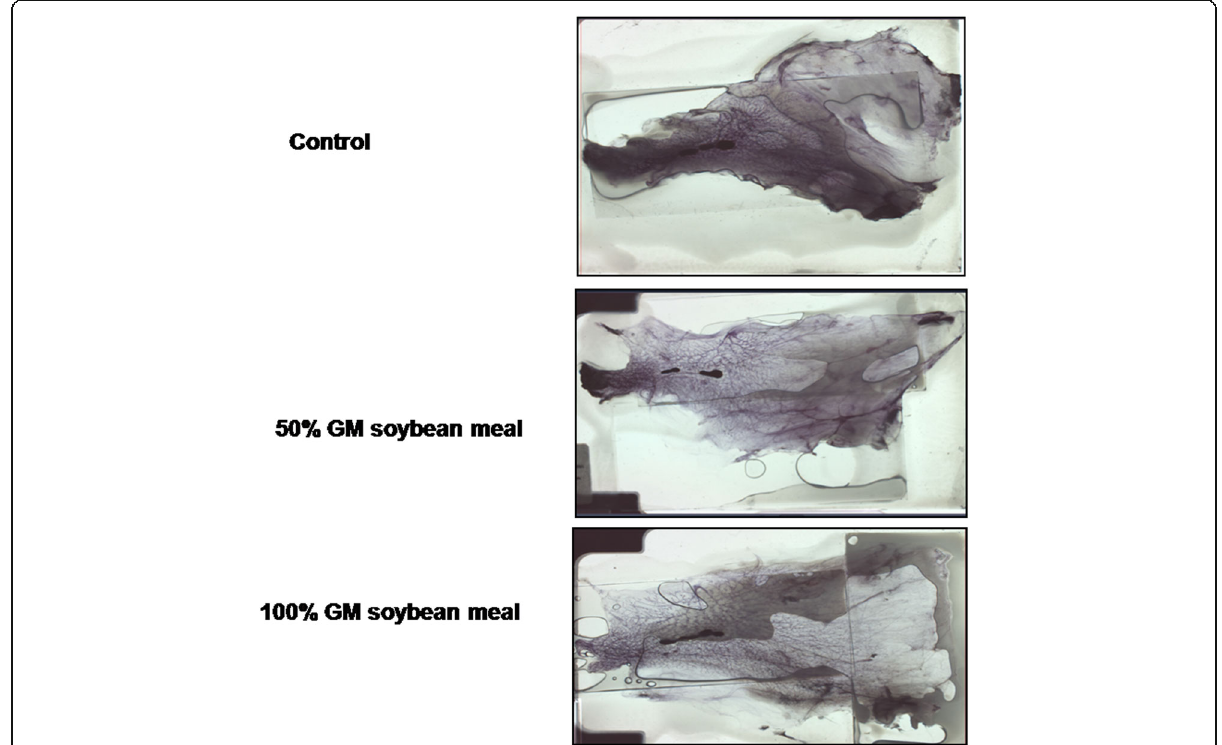
Fig. 5 Whole mount preparations for the inguinal mammary glands of female Wistar rats showing morphological changes and increase in the